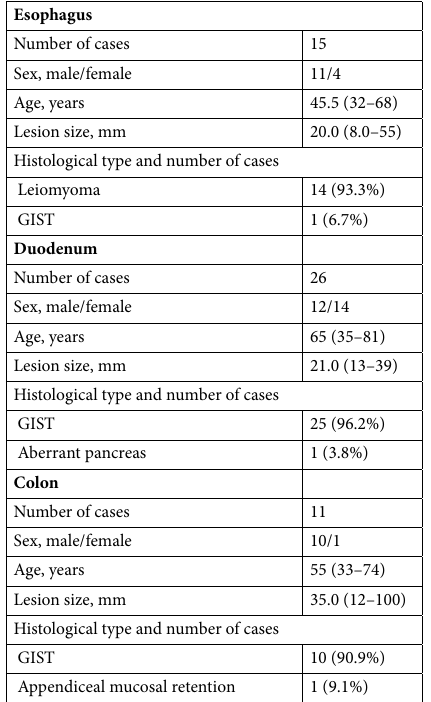
Table 2. Patient and lesion characteristics of esophageal, duodenal, and colonic lesions. Values are presented as n, median (range), or n (%). GIST, gastrointestinal stromal tumors.